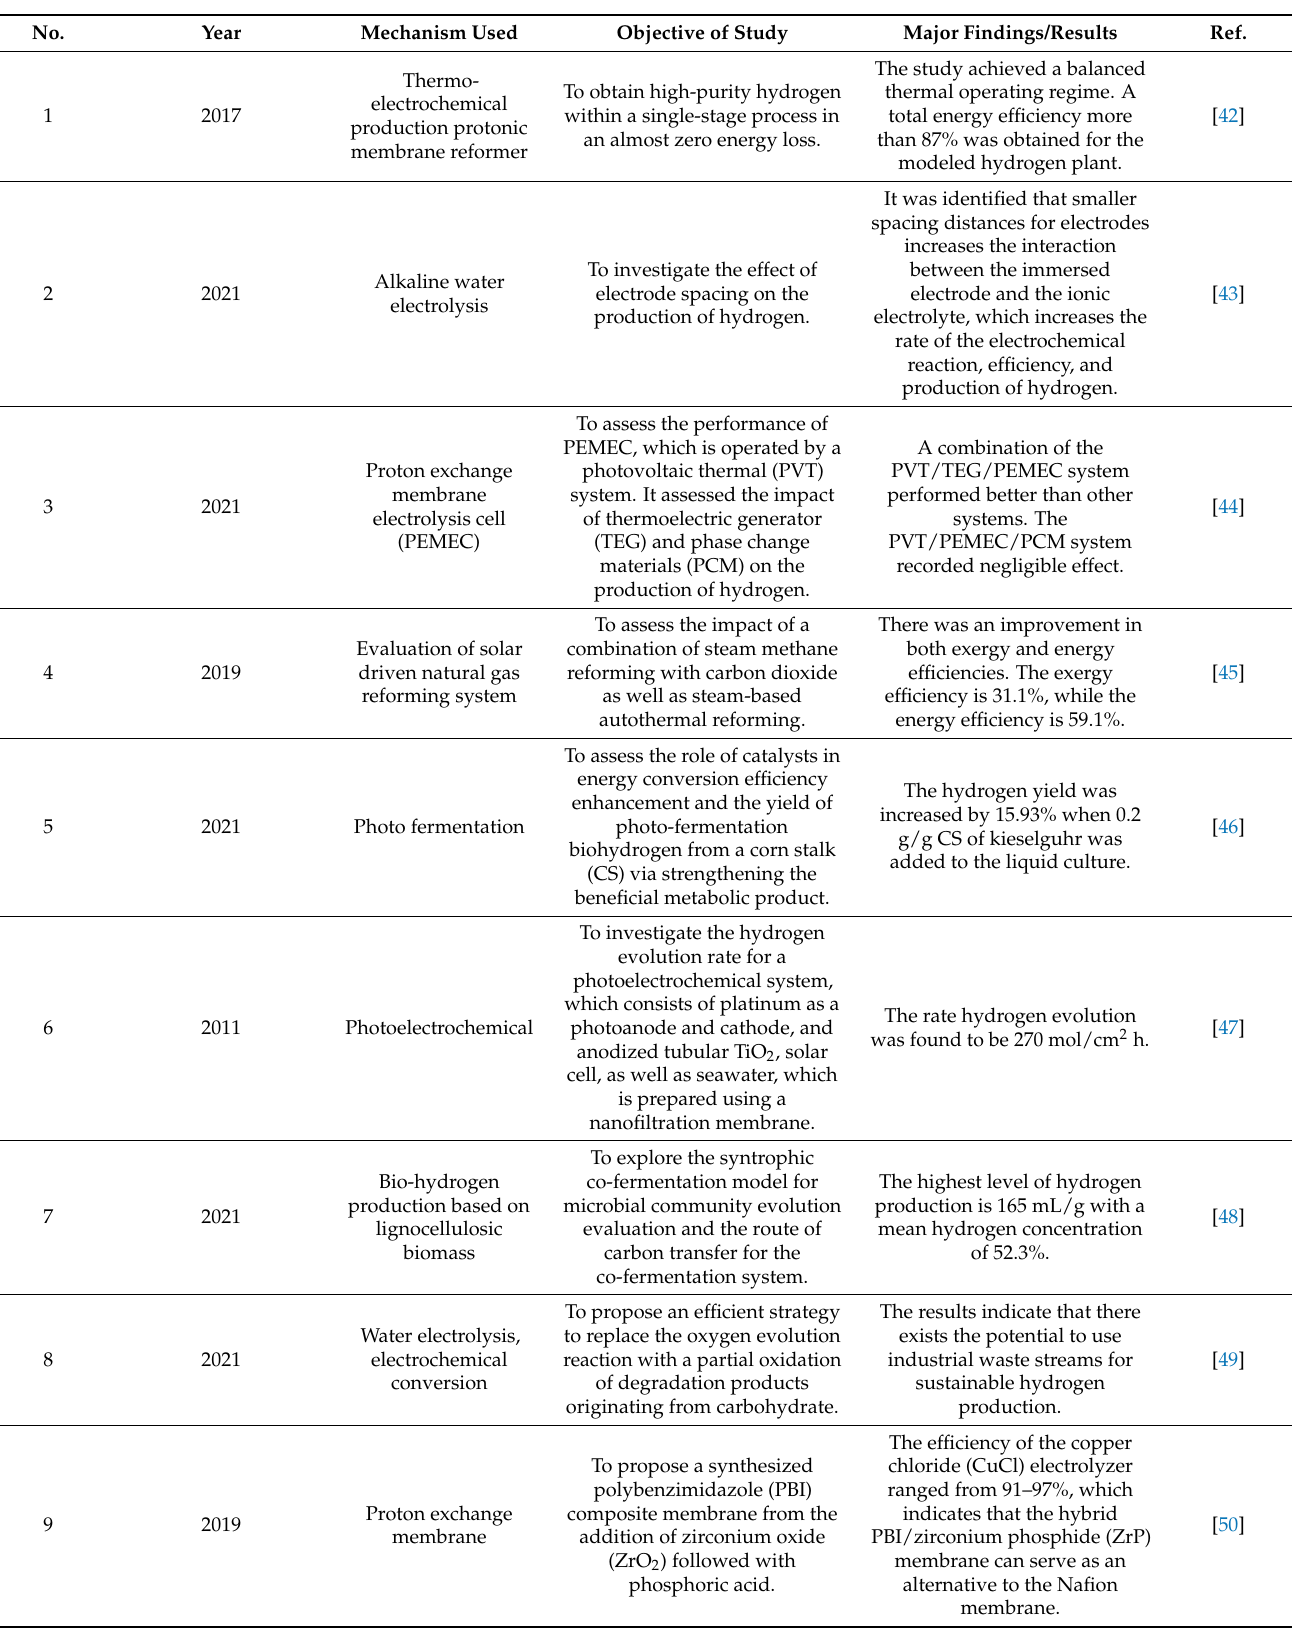
Table 1. Recent studies on the production of